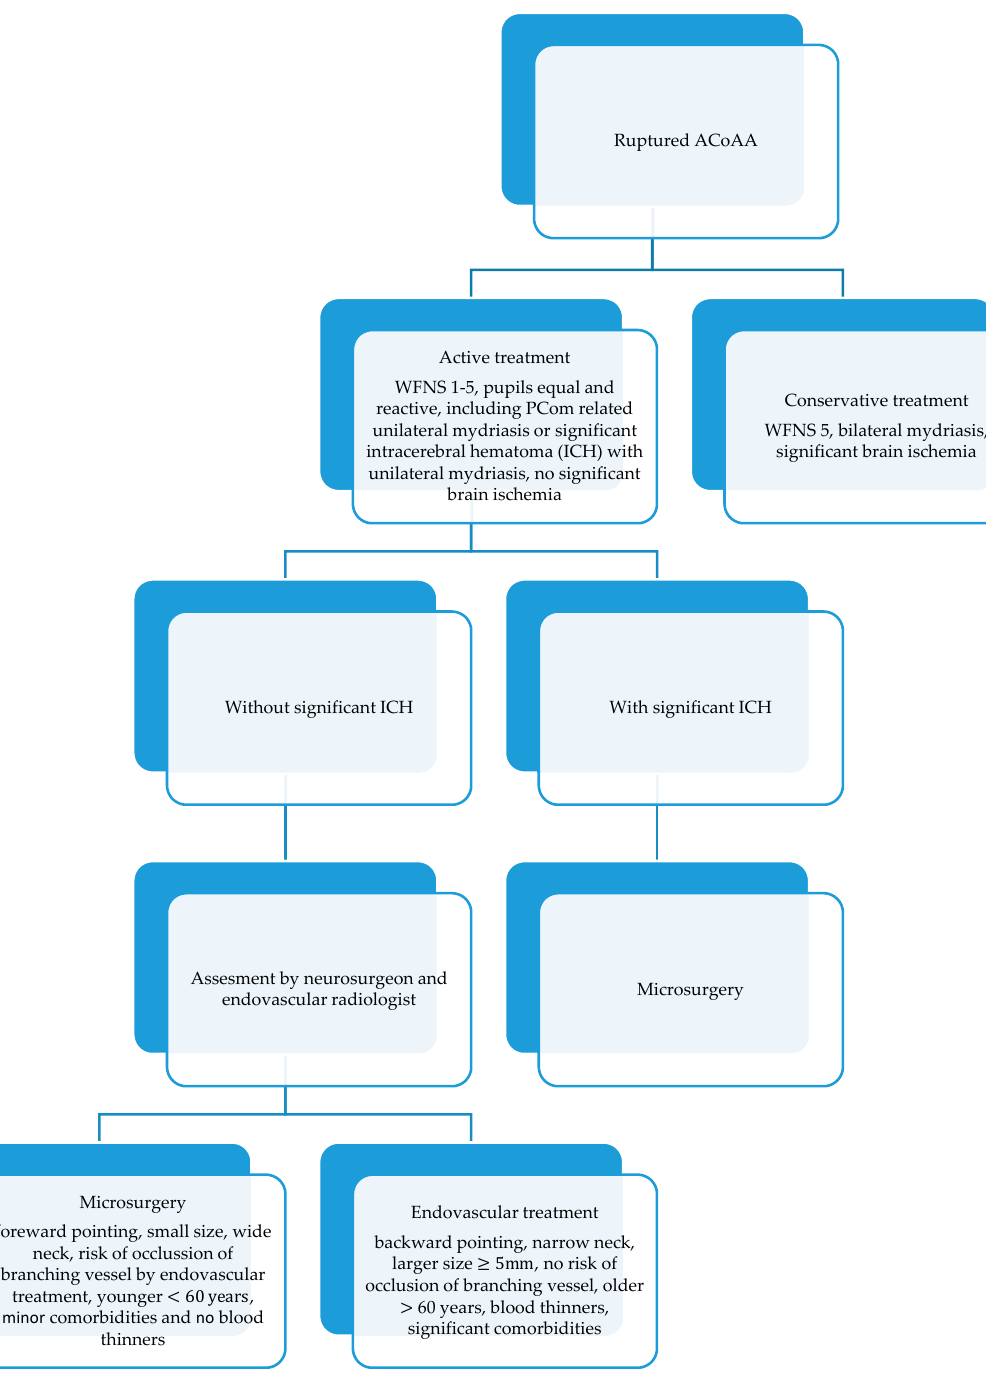
Figure 1. Management of ruptured anterior communicating artery aneurysms (ACoAA) in the center- simple algorithm.